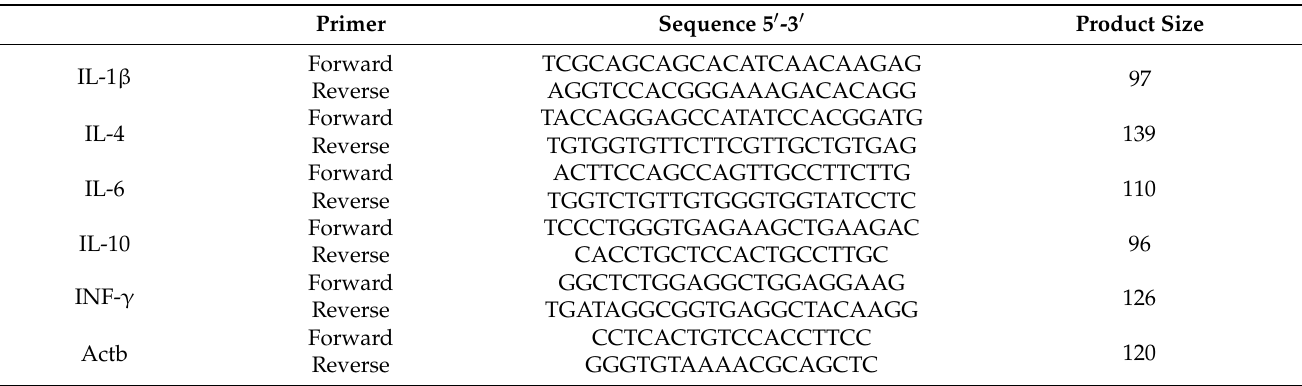
Table 5. The Primers sequences used for